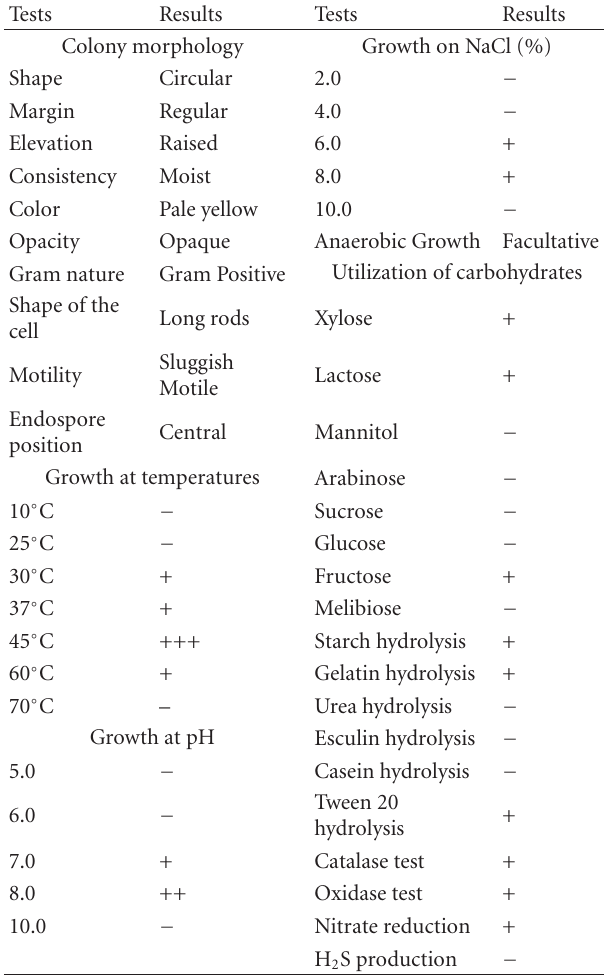
Table 1: Morphological, physiological, and biochemical character- istics of the